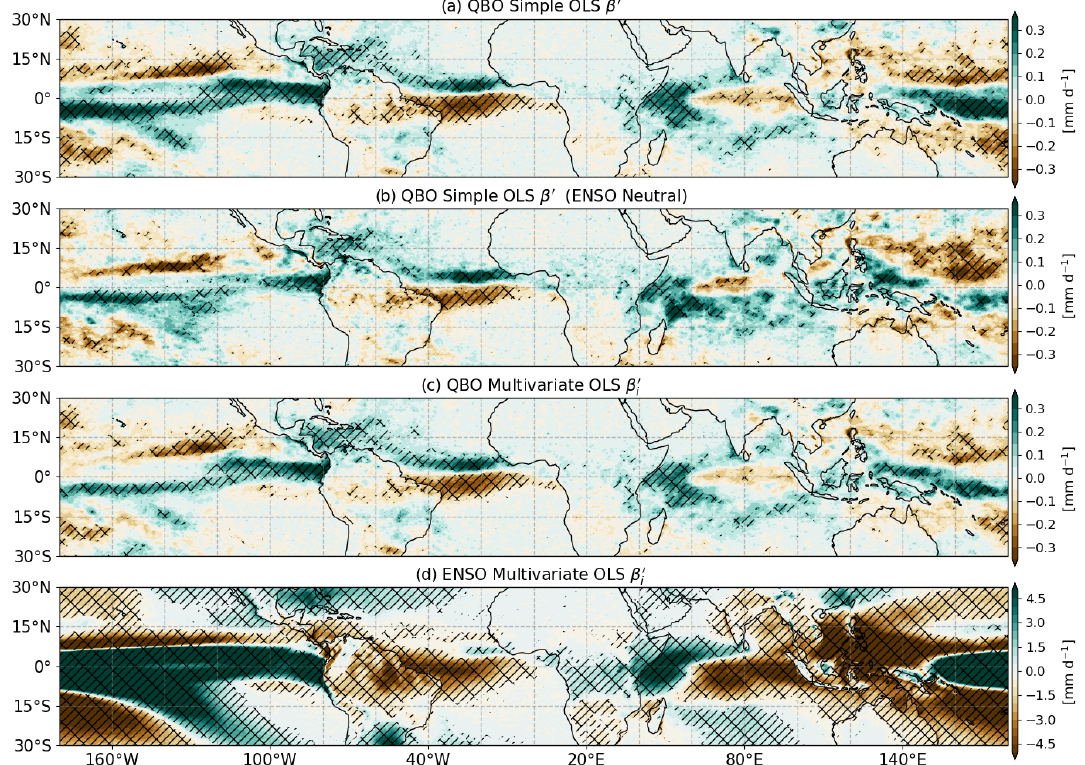
Figure 5. Annual-mean regression model results in GC3 N216-pi for convective precipitation. (a, b) Rescaled regression coefficients ( β (cid:48) from a simple ordinary least-squares (OLS) regression model with the QBO index for (a) all months and (b) ENSO-neutral months only. Panels (c) and (d) show the regression coefficients resulting from a multivariate regression model using the ENSO and QBO indices for the (c) QBO and (d) predictors. In all cases, the regression coefficients are rescaled by multiplying the regression coefficients by the ratio of maximum amplitude and standard deviation of the QBO or ENSO indices, and the hatching indicates significance to the 95% confidence level based on a t